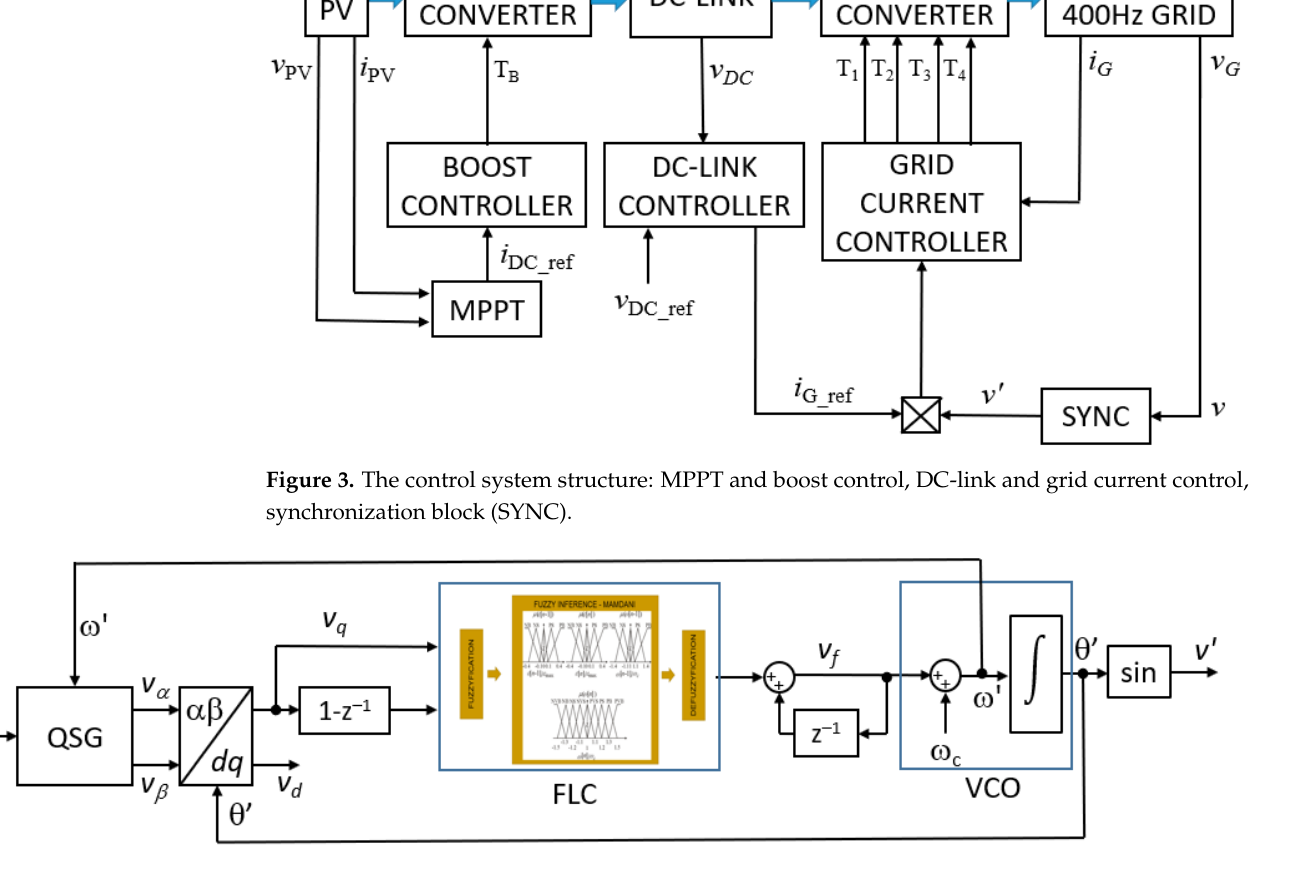
Figure 4. The fuzzy logic-based synchronizer.